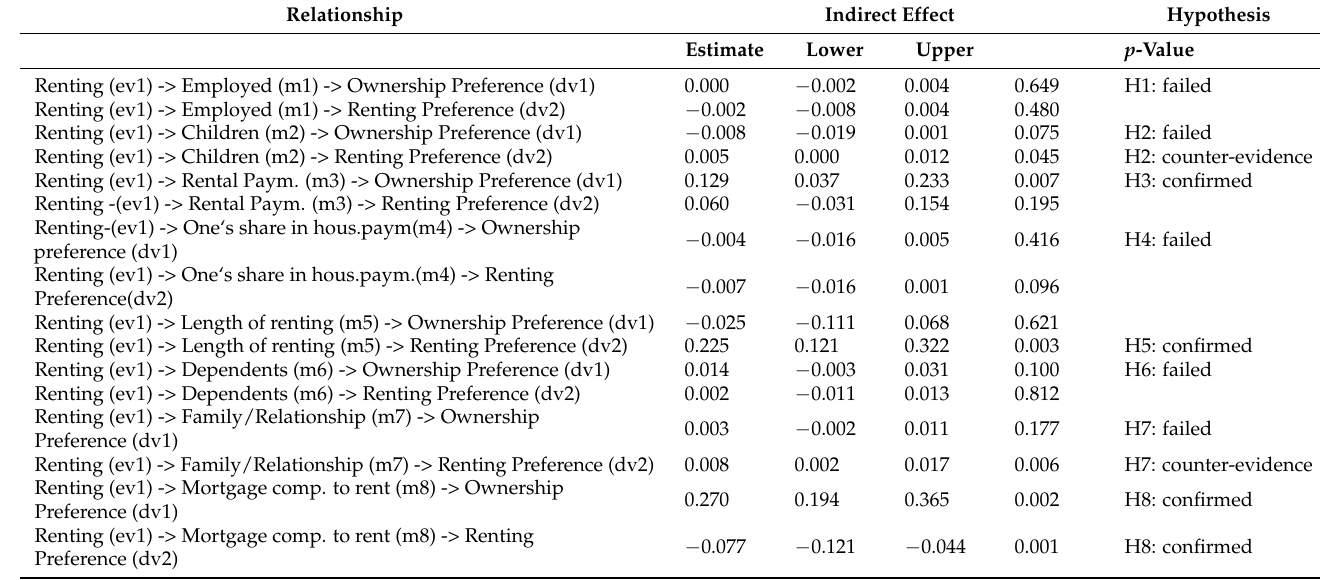
Table 9. Verification of the hypotheses tested in the